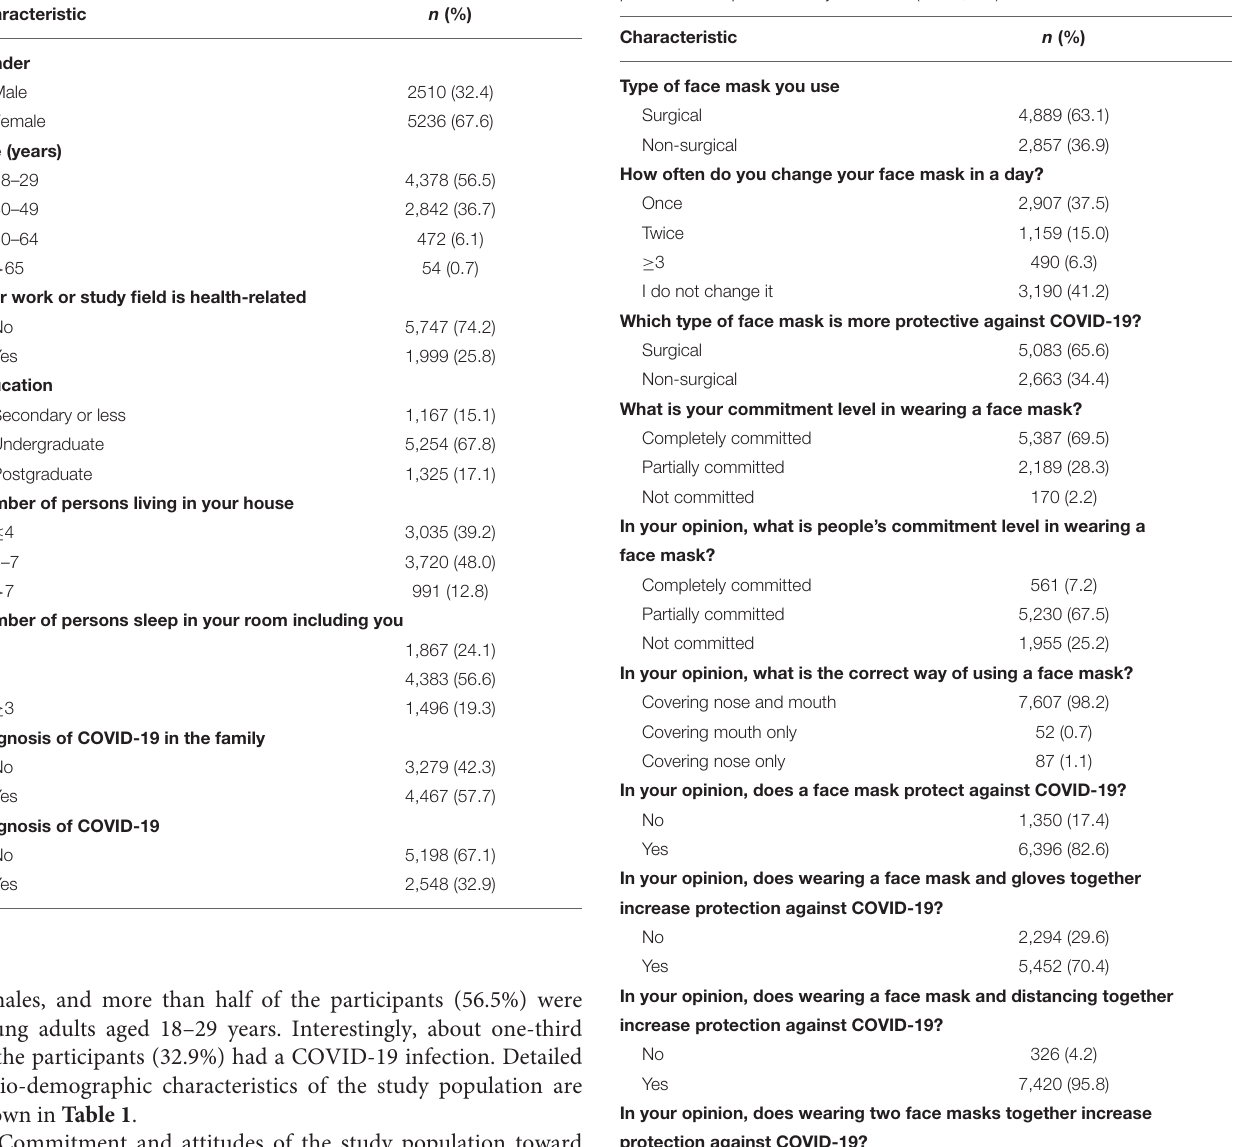
TABLE 1 | Socio-demographic characteristics of the study population ( n = 7,746). Characteristic